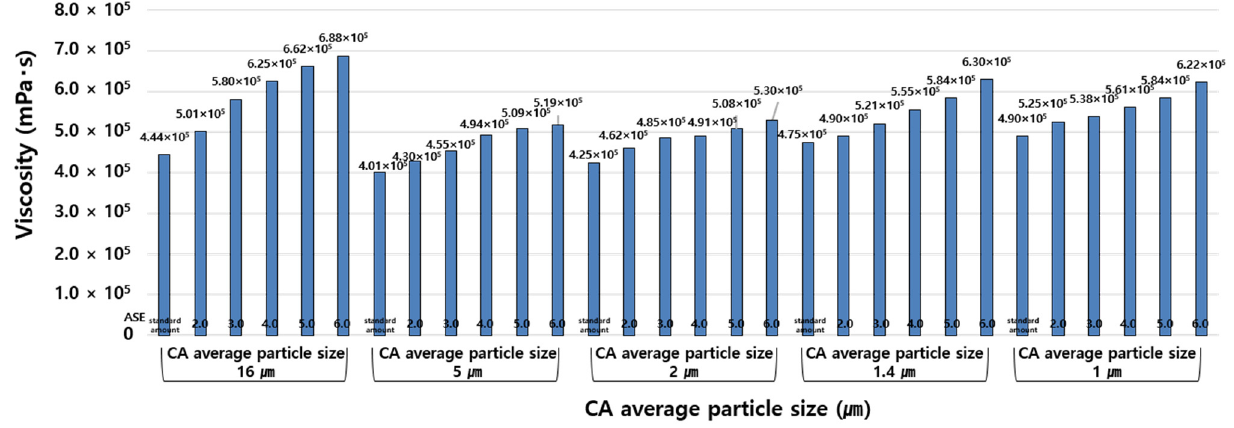
Figure 8. Graph of viscosity measurement results.